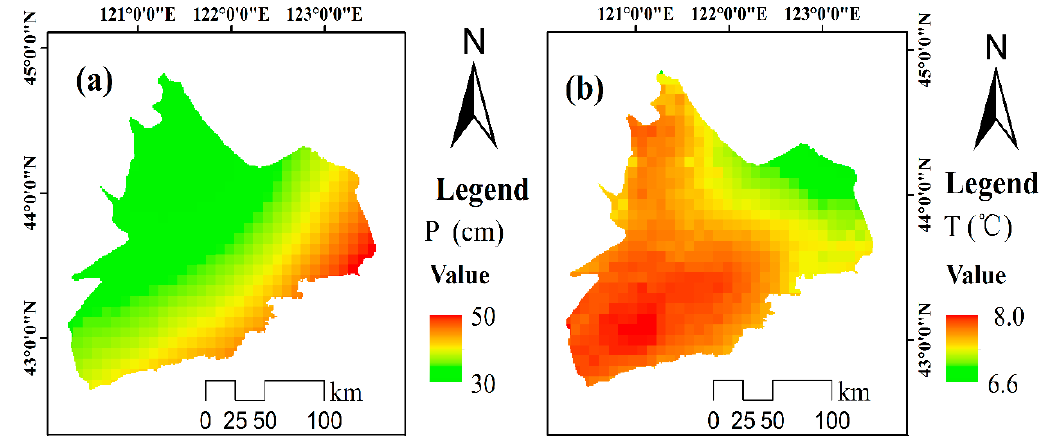
Figure 4. Spatial distribution of P ( a ) and T ( b ) from 2002 ~ 2014 (Grid cell size: 1 km).